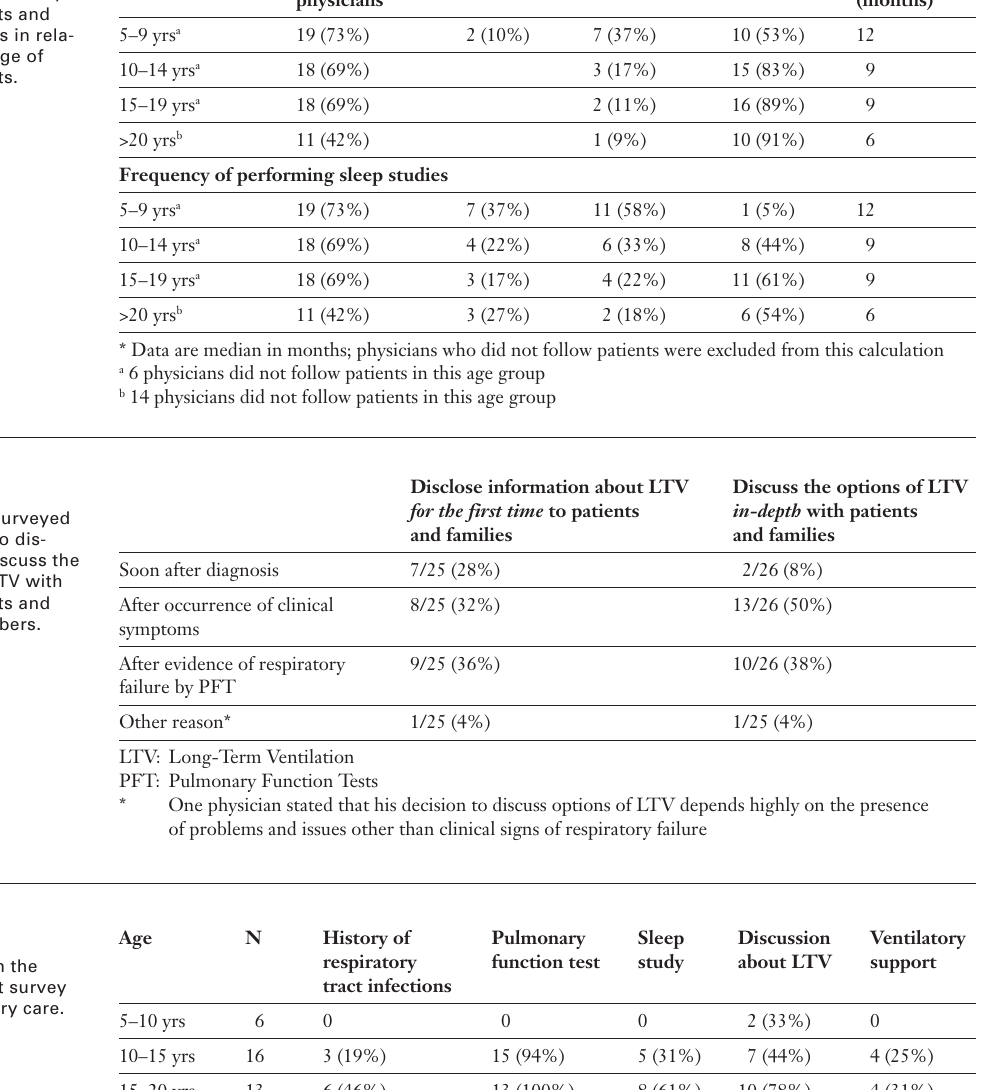
Frequency of per- forming pulmonary function tests and sleep studies in rela- tion to the age of DMD patients.